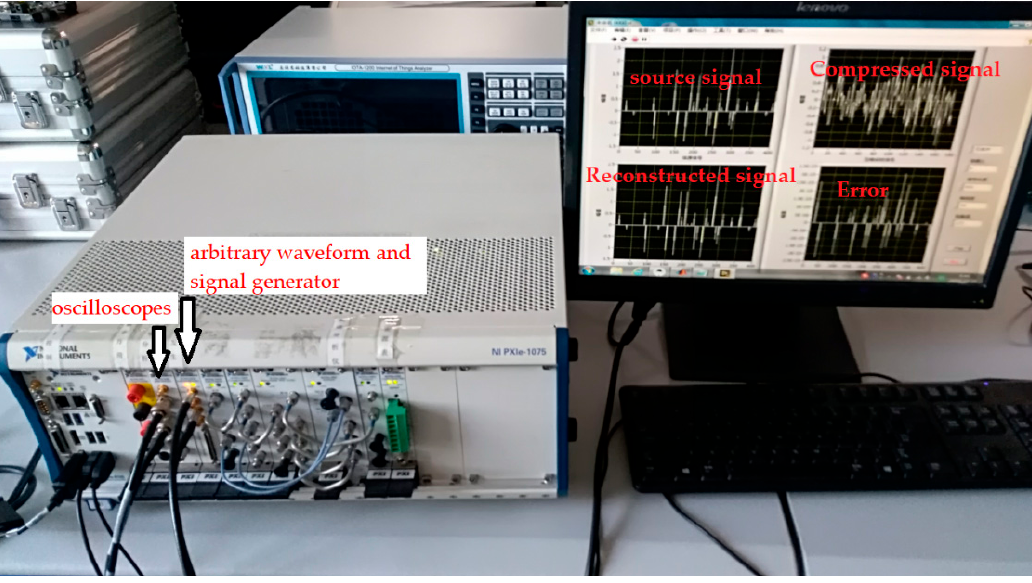
Figure 15. Measurement device for real applications.